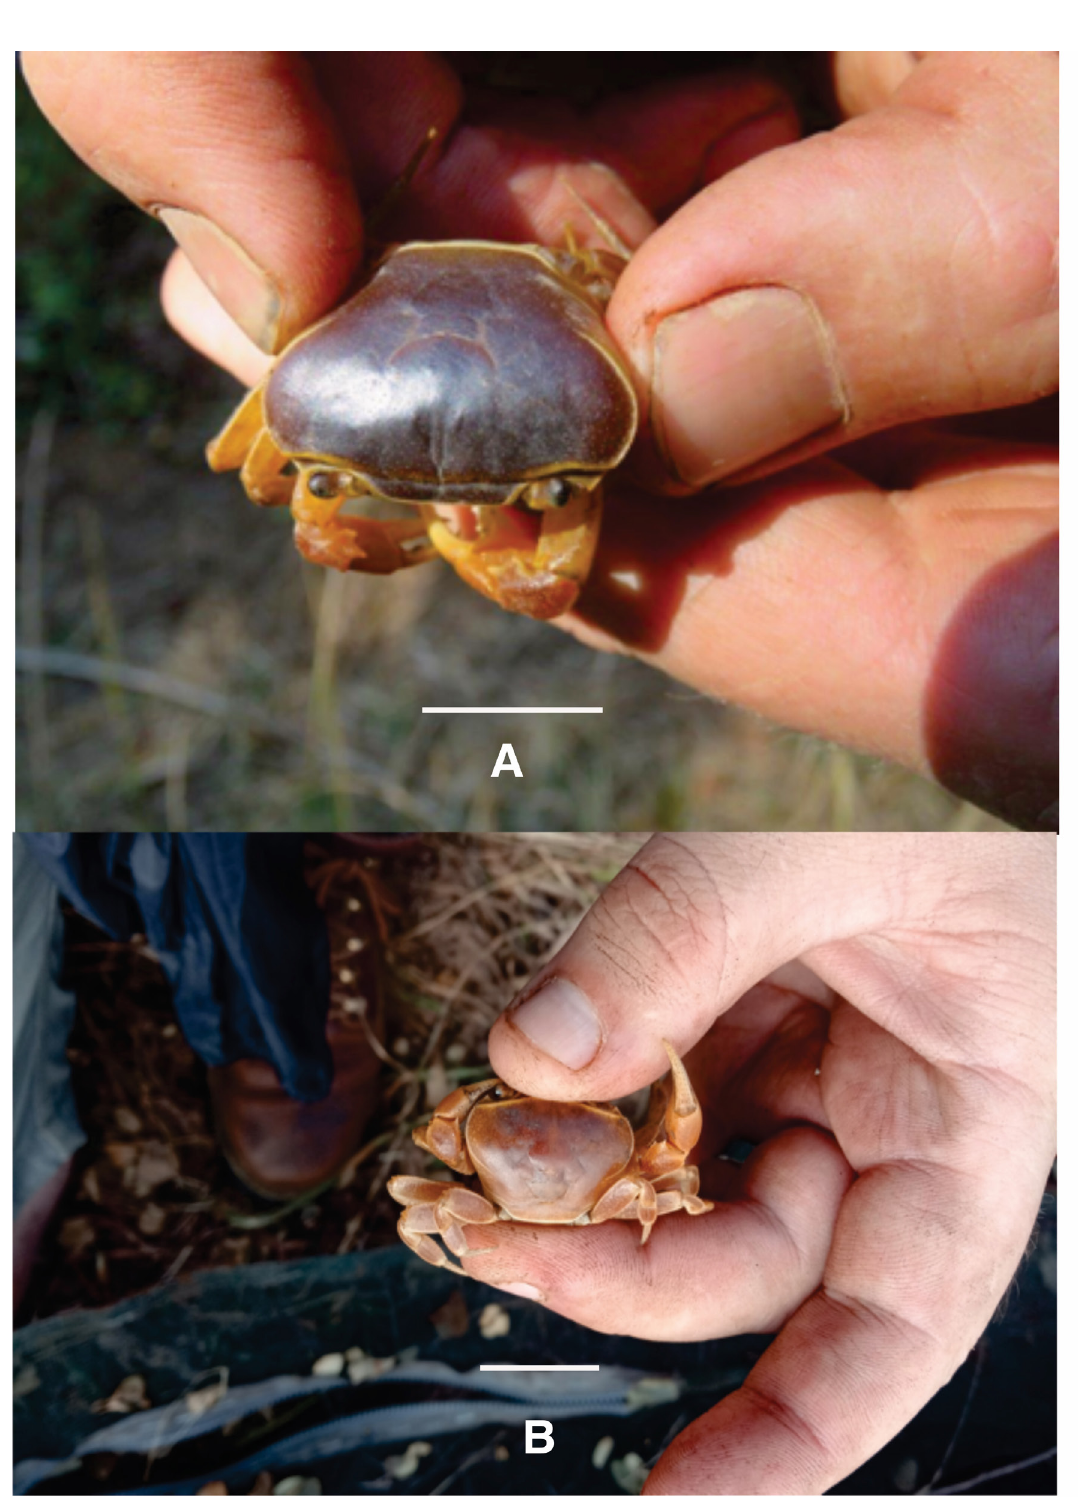
Fig. 5. A . Dorsal image of Potamonautes mariepskoppie sp. nov., when alive taken at the Blyde Canyon Nature Reserve, Mpumalanga Province, South Africa. B . Dorsal image of P. mariepskoppie sp. nov., of the specimen collected at Haenertsburg, Limpopo Province, South Africa. Scale bars = 10